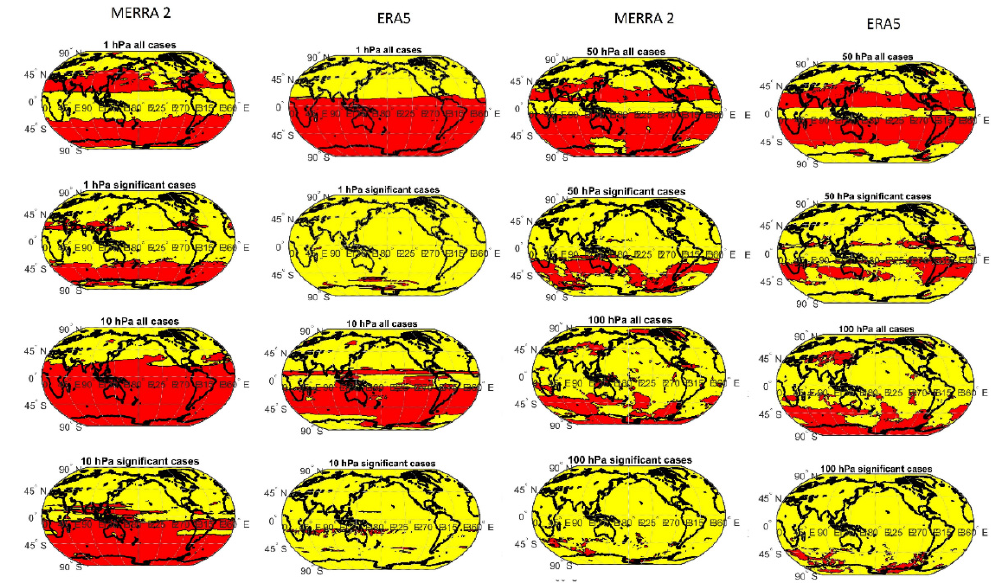
Figure 2. Temperature climatology for January, period 2004–2018. ERA5 reanalysis on the top panels, GPS RO on middle panels, and MERRA2 on the bottom panels for pressure levels 1, 10, 50, and 100 hPa.